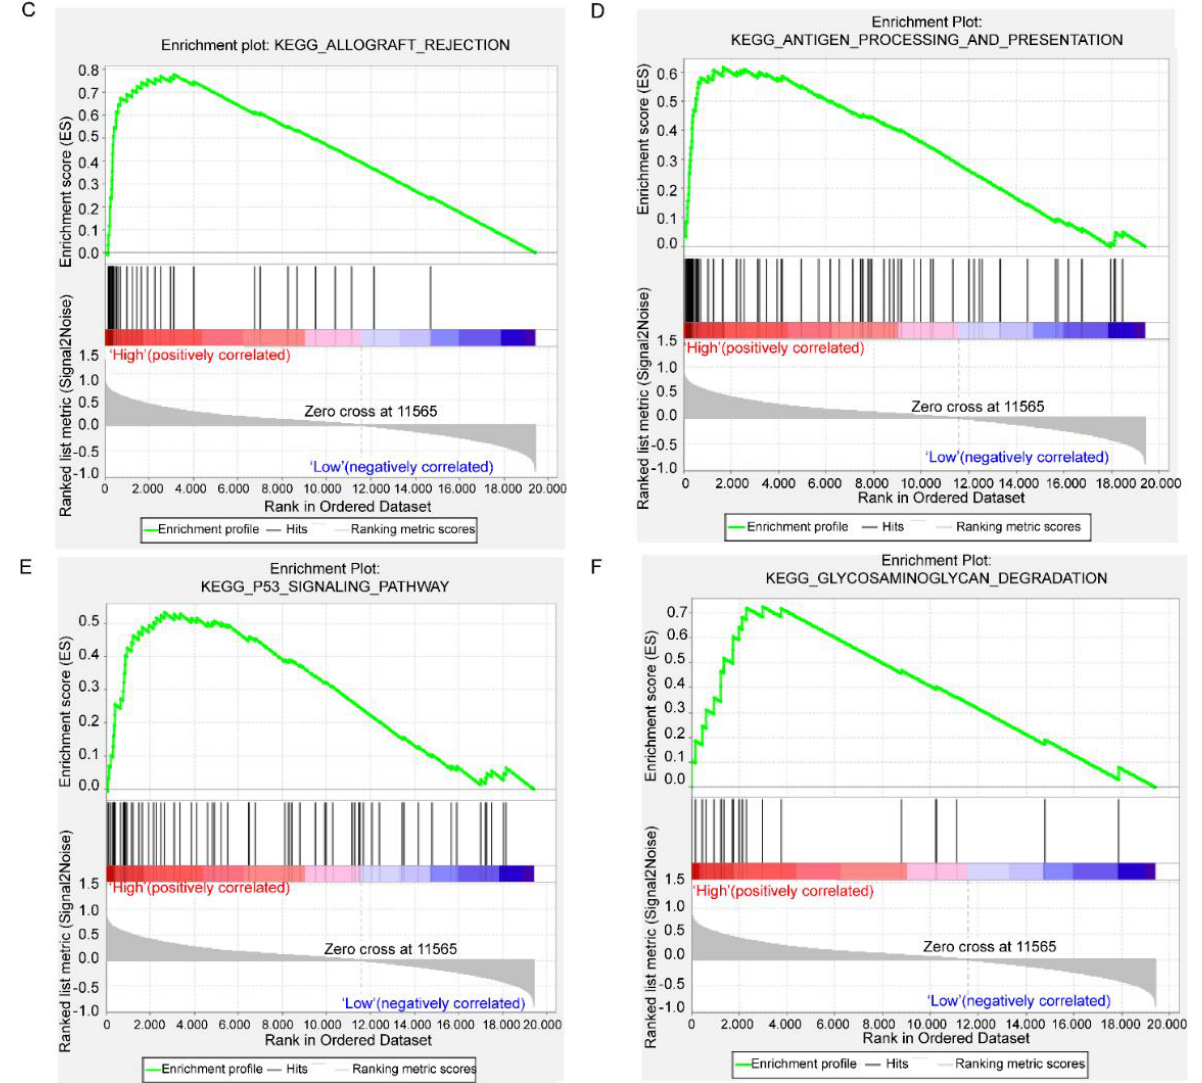
Figure 6. The results of GSEA enrichment of RAB42 . ( A – F ) Sys-temic Lupus Erythematosus, Au- toimmune Thyroid Disease, Allograft Rejection, Antigen Processing and Presentation, P53 Signaling Pathway, and Glycosamino-glycan